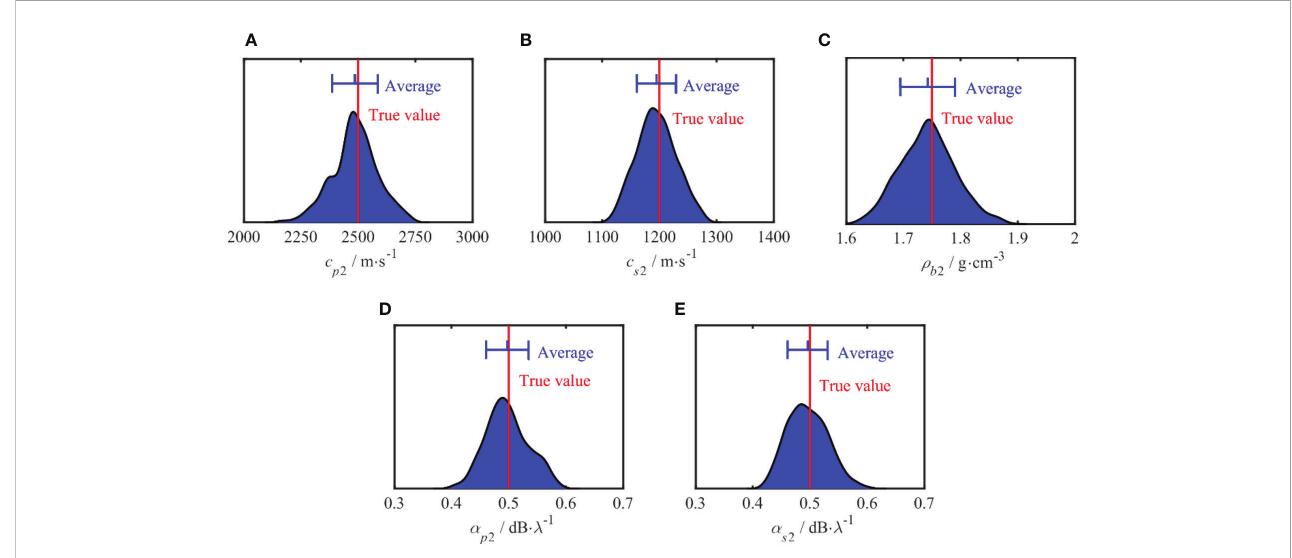
FIGURE 8 One-dimensional marginal probability distribution of semi-in fi nite parameters. The red line represents the true values of each parameter in the simulation. The blue segments represent the average value and the standard deviation.